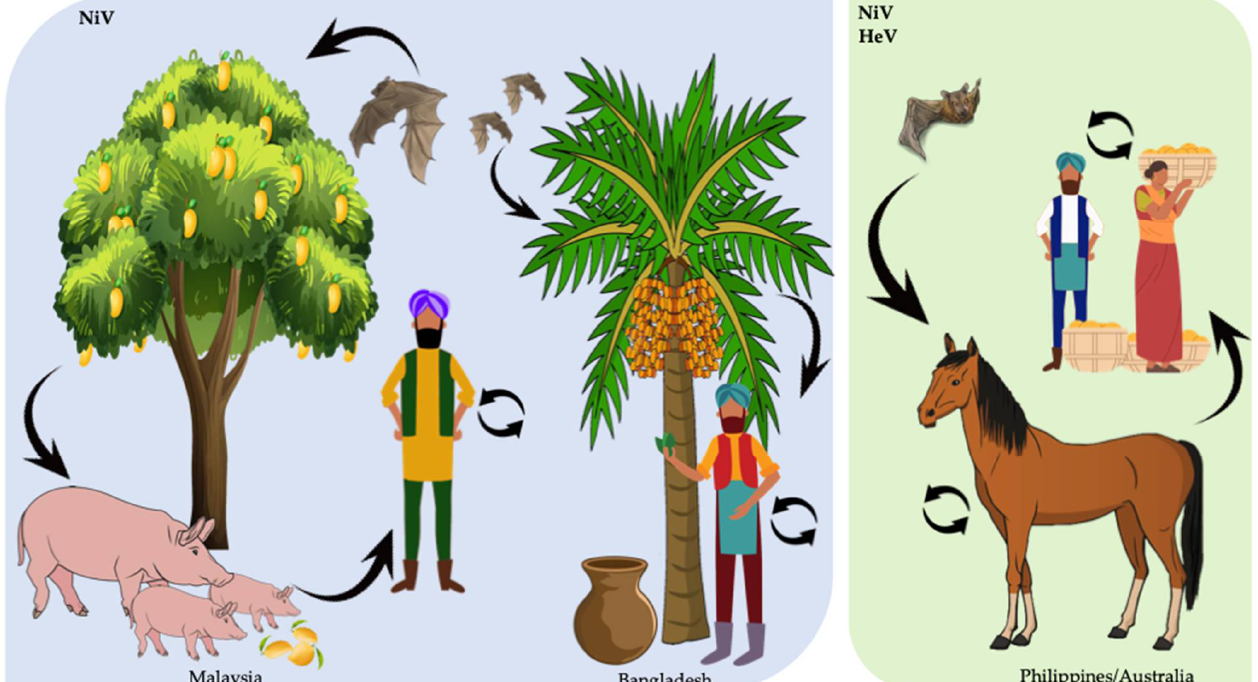
Figure 2. Major routes of NiV and HeV transmission. NiV and HeV natural reservoir are Pteropid spp. bats. NiV transmission in Malaysia mostly occurs when pigs consume partially eaten fruit contaminated with NiV-containing feces, urine, or saliva. Subsequently, humans in close contact with pigs contract NiV and can transmit it to other humans. In Bangladesh, NiV is believed to be transmitted mainly through consumption of date sap. When bats drink from the palm sap stream or collection recipients, they contaminate it with NiV via saliva or urine and humans can contract NiV after consuming contaminated palm sap. Infected people can in turn transmit NiV to other people. In the Philippines and Australia, bats can transmit NiV or HeV to horses which will become amplifying hosts and can transmit the viruses to humans and other horses through close